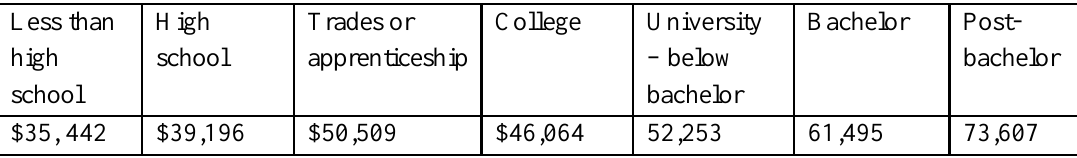
Median 2005 Earnings for Full-Year, Full-Time Earners by Education, Both Sexes, Total—Age group 25 to 64, for Canada, Provinces and Territories—Alberta Less than High Trades or College University Bachelor Post- high school apprenticeship – below bachelor school bachelor $35, 442 $39,196 $50,509 $46,064 52,253 61,495